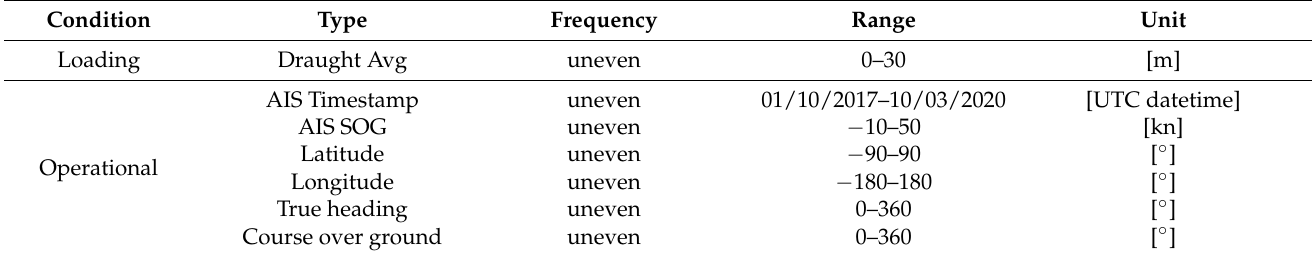
Table 3. Sampling frequency, acquisition range and units of AIS